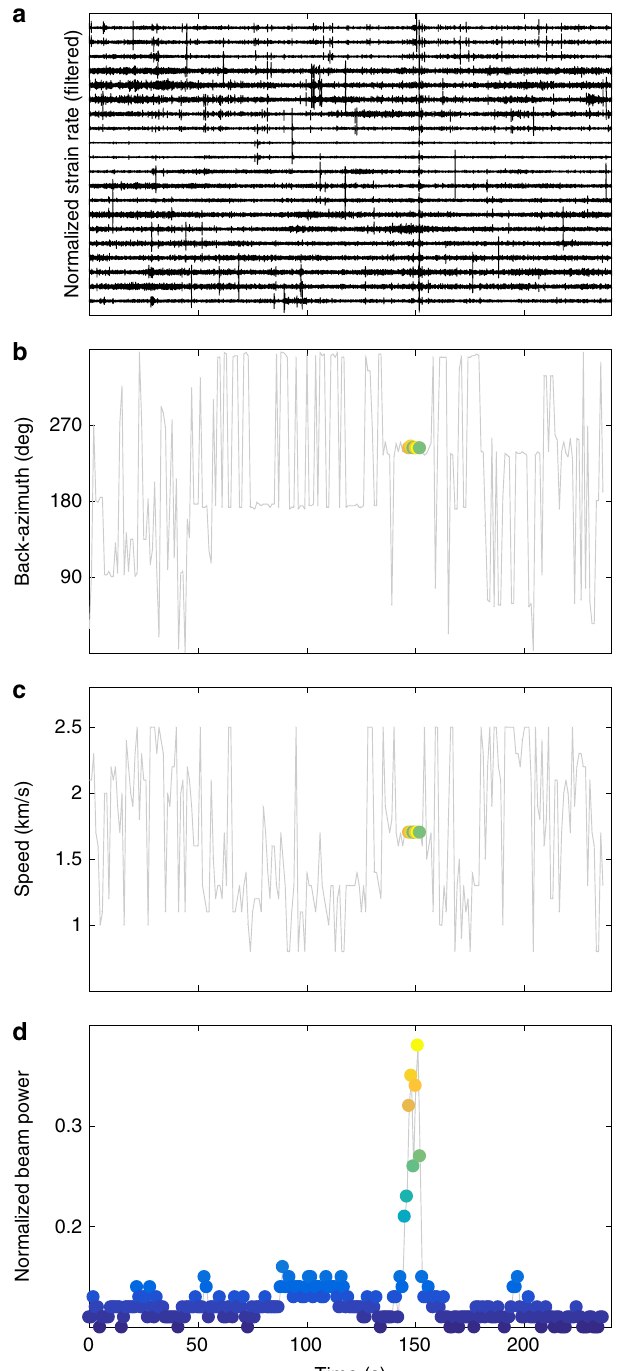
Fig. 5 Matched- fi eld processing (MFP) of a DAS rock-fall seismogram. a 20 DAS channels fi ltered between 10 and 30 Hz. Notice the frequent occurrence of noise transients at amplitudes comparable to the rock-fall signal around 150 s. b Calculated back azimuth. c Calculated phase speed. d Normalized beam power showing a sudden increase of signal coherence within the DAS channels when the rock-fall signal is recorded. Color code represents normalized beam power and is the same as in panels ( b ) and ( c ). This shows that during the rockfall, the calculated back azimuths and phase velocities are stable, but jump between the grid search extremes at other times. During the rock-fall signal, back azimuth and phase velocity are consistent with Rayleigh waves emitted by visually observed rock impacts on the ground west of the instrumented